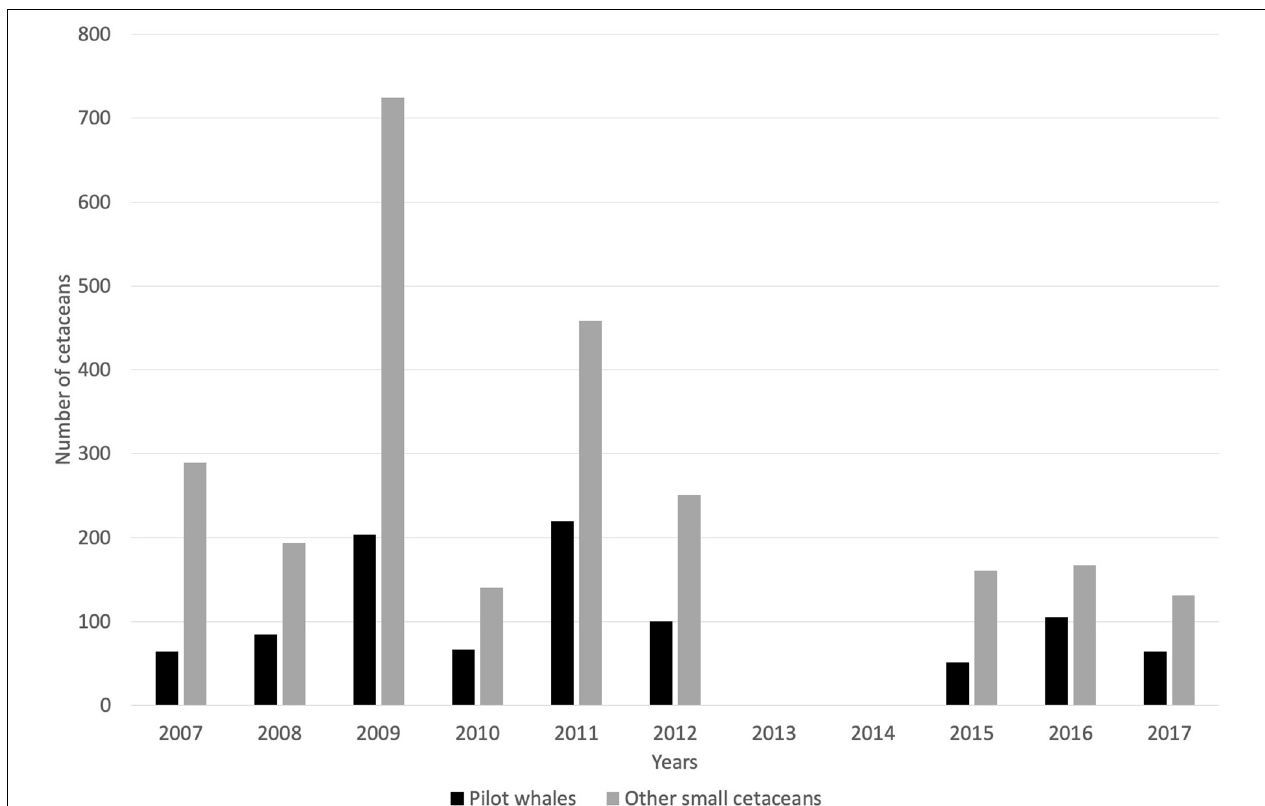
FIGURE 4 | Catch records for small cetaceans taken by a single whaling boat from 2007 to 2017 (no data available in 2013 and